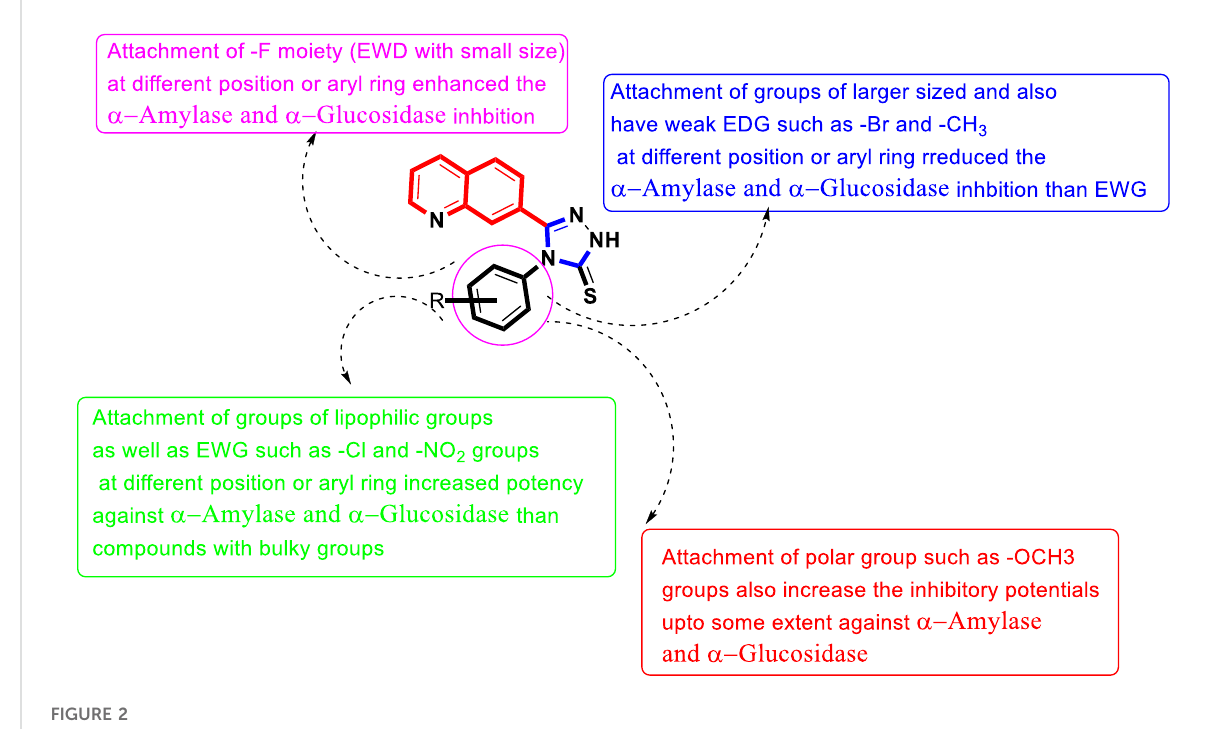
FIGURE 2 Summary of SAR studies of quinoline-based triazole against α -amylase and α -glucosidase